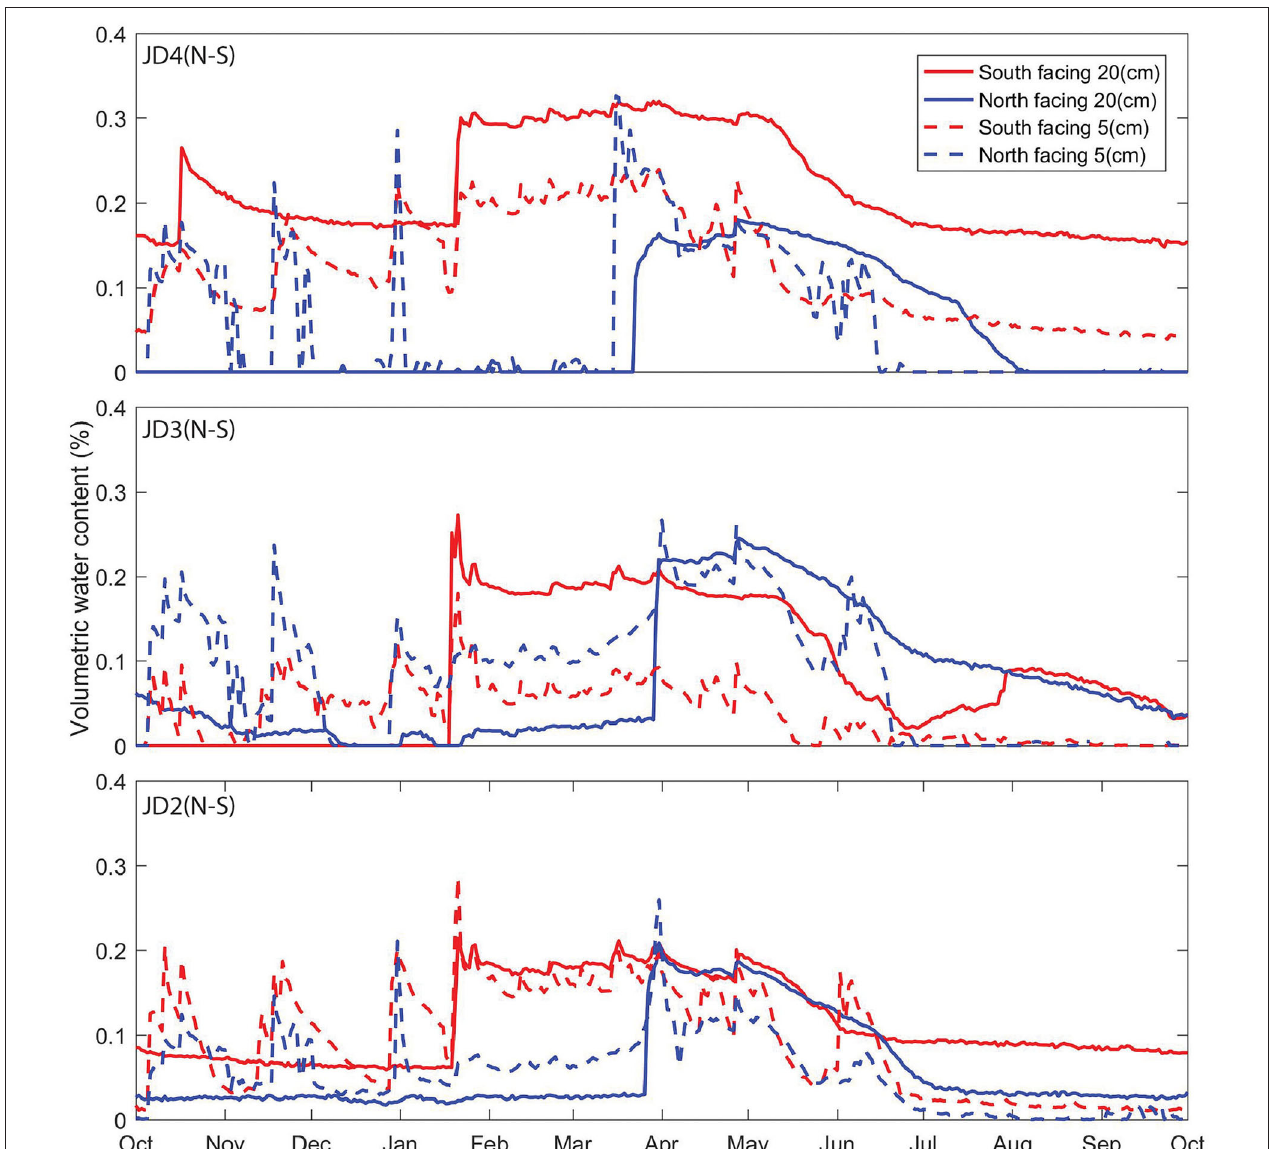
FIGURE 4 | Volumetric water content at 5 and 20cm depth measured at the JD2(N–S), JD3(N–S), and JD4(N–S) instrument sites for the 2012 water year. The blue and red lines indicate the instruments on the north and south facing slopes, respectively; and the solid and dashed lines indicate 20 and 5cm depth, respectively. In the winter months the south facing slope are continuously wet, while the north facing slopes remain dry until late March, when moisture infiltrates into the soil column in a single large